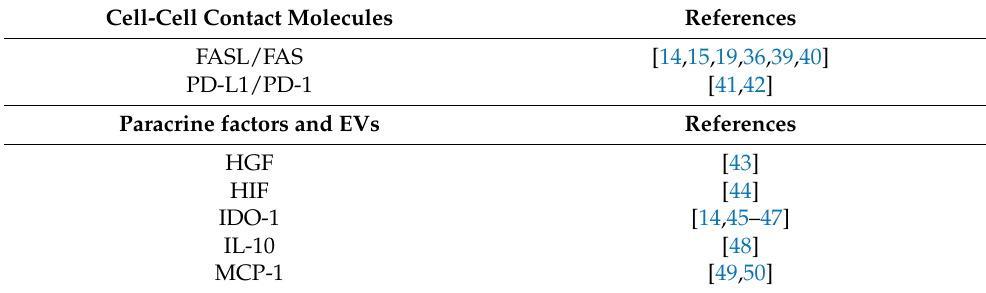
Table 1. Molecules and extracellular vesicles (EVs) in immunosuppressive functions of hDPSCs. Cell-Cell Contact